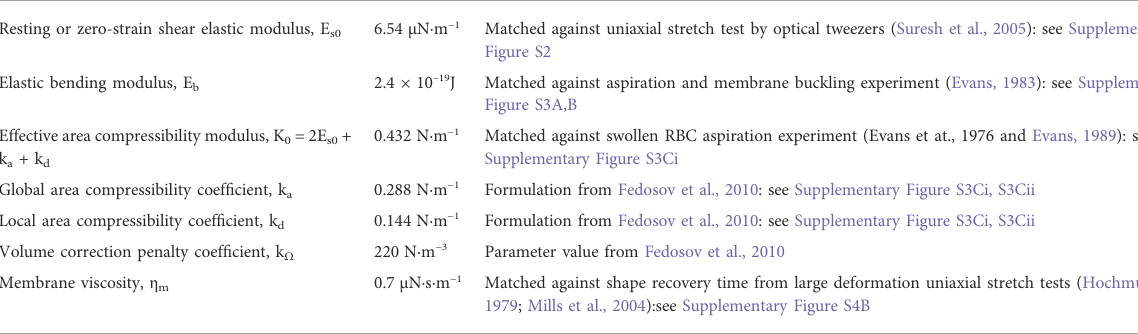
TABLE 1 Mechanical properties of the RBC employed in simulation